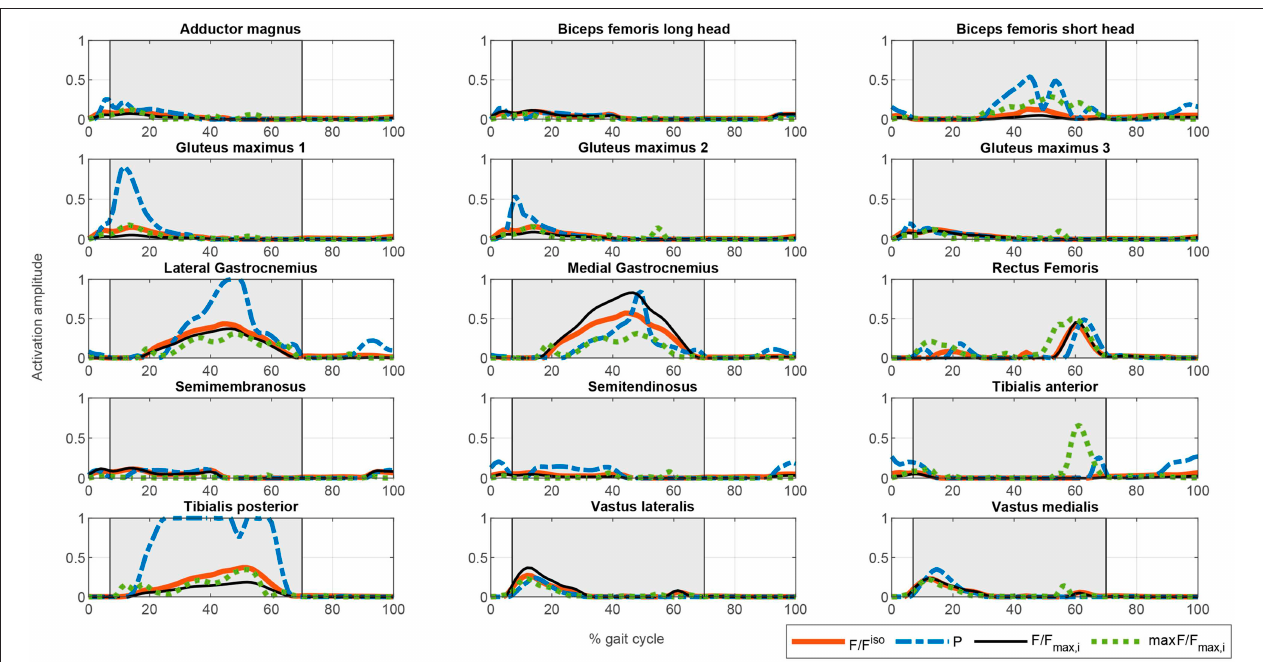
FIGURE 4 | Comparison of the different activation profiles for the proposed optimization cost functions. CF1: Thick solid orange line. CF2: Dashed blue line. CF3: Thin solid black line. CF4: Dotted green line.